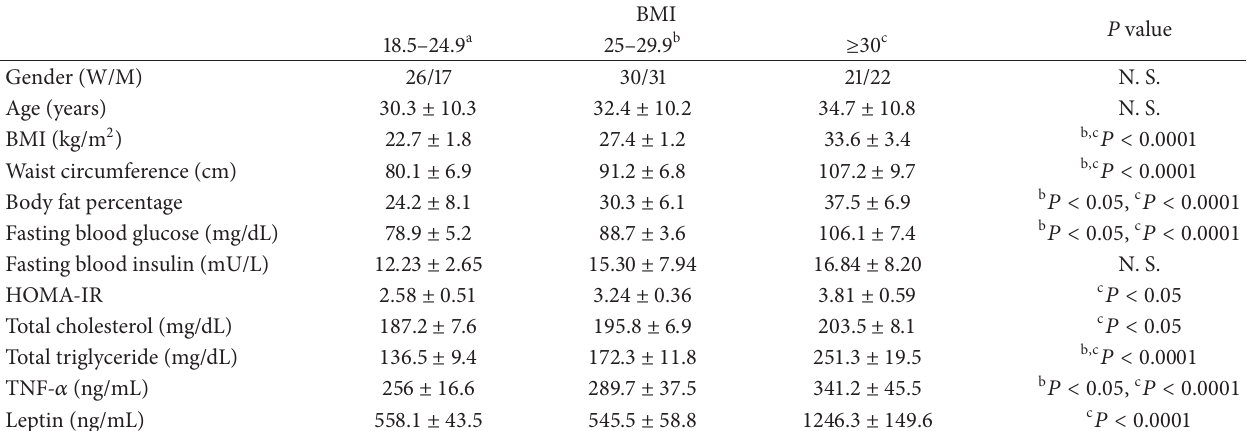
Table 1: Anthropometric and biochemical characteristics of the study subjects.